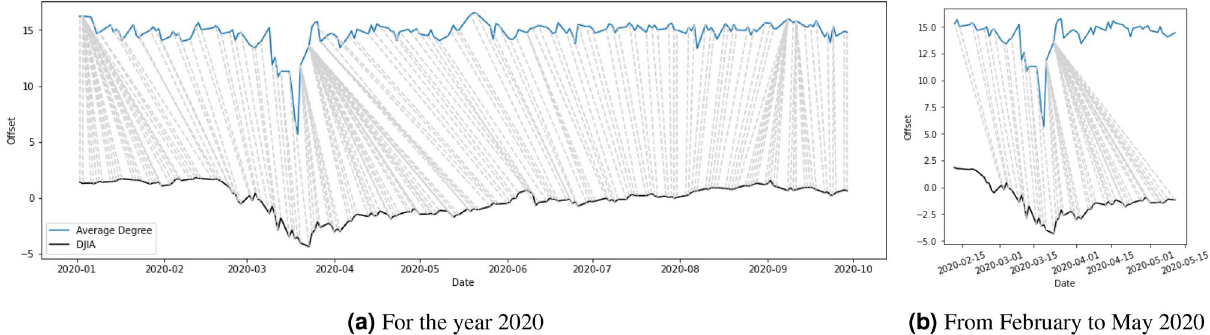
Figure 9. Dynamic time warping: point-by-point comparison between average degree and DJIA for the year 2020, both series normalised.